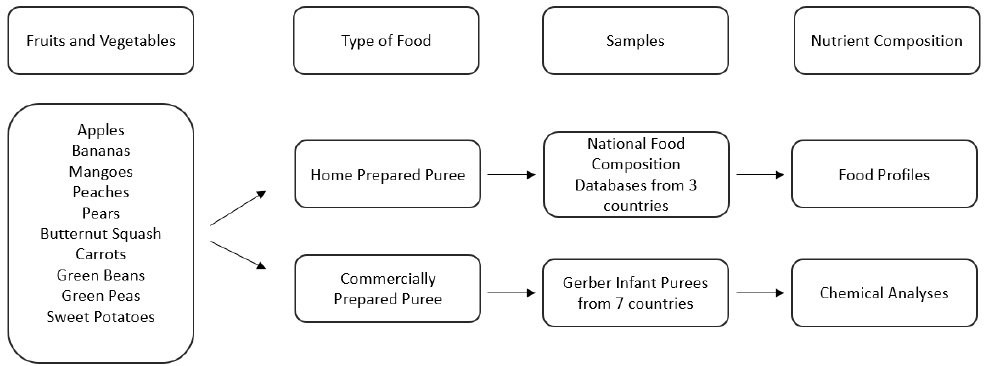
Figure 1. Description of sample selection and analysis of Study 1.